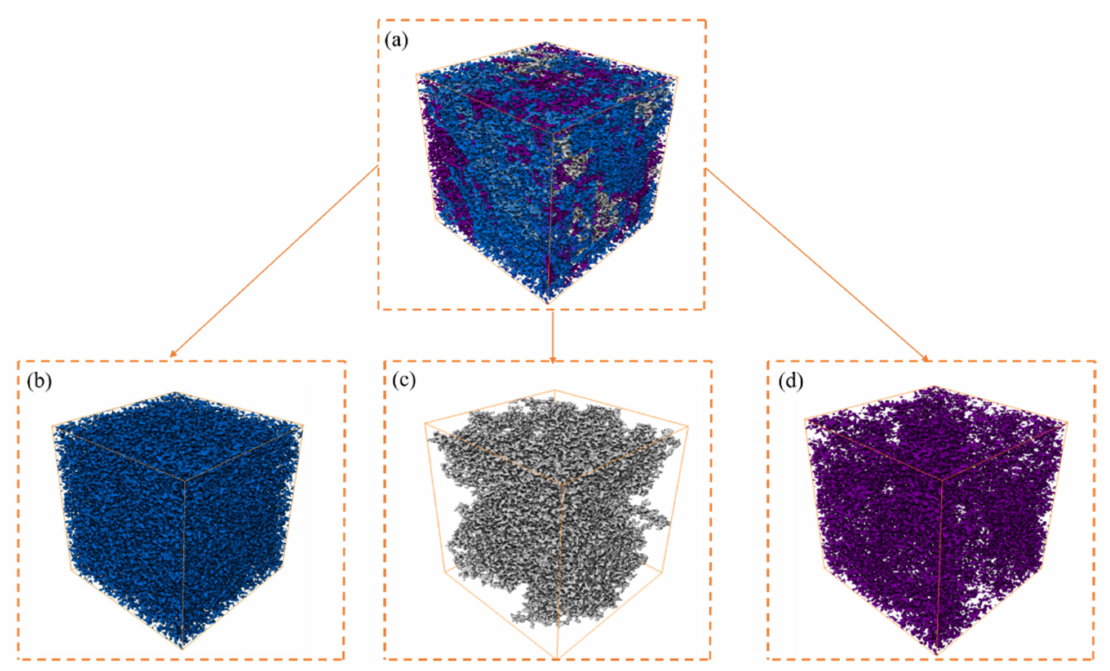
Figure 8. 3D digital core model ( a ). visualization of the pores( b ), connected pores( c ) and non- connected pores ( d ) of sample